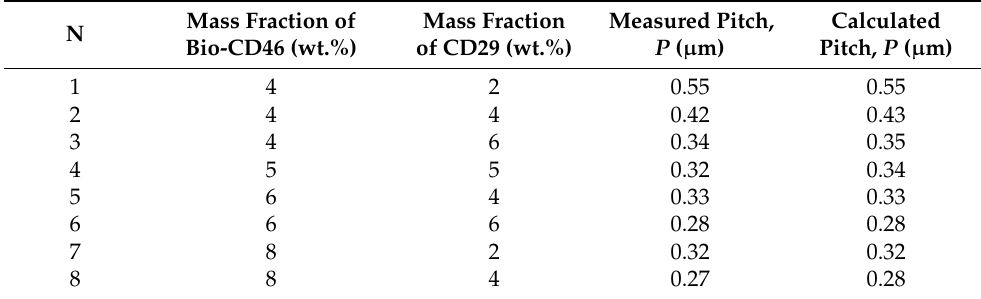
Table 3. Pitch measurements for ternary mixtures consisting of bio-CD46 and CD29 chiral dopants in E7 nematic host. Measured pitch is compared to theoretical prediction of pitch for ternary mixtures. Mass Fraction of Mass Fraction Measured N Bio-CD46 (wt.%) of CD29 (wt.%)